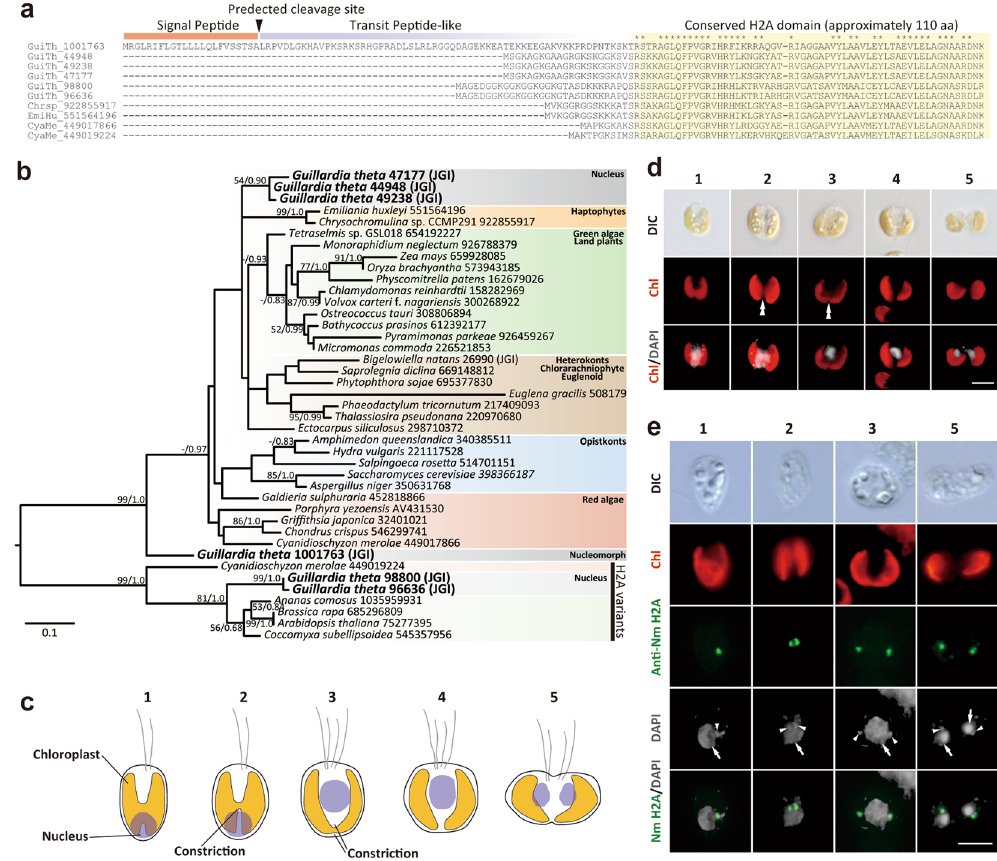
Figure 2. Identification of the nucleus-encoded nucleomorph-targeted histone H2A in G . theta . ( a ) Alignment of the N-terminal sequences of histone H2A proteins. The N-terminal of the G . theta histone H2A (GuiTh_1001763) is composed of a signal peptide and a transit peptide-like sequence. No signal peptide is predicted in other G . theta nucleus-encoded histone H2A (GuiTh_44948, GuiTh_49238 and GuiTh_47177) or histone H2A variants (GuiTh_98800 and GuiTh_96636). Histone H2A sequences of the haptophyte Chrysochromulina sp. CCMP2919 (GI#922855917), the haptophyte Emiliania huxleyi (GI#551564196), and the red alga Cyanidioschyzon merolae (GI#449017866 and GI#449019224) were also used for the alignment. The asterisk indicates an amino acid that is identical in all sequences and the conserved region is boxed in yellow. ( b ) Phylogenetic tree of histone H2A inferred from 105 amino acid sequences. The histone H2A sequences of G . theta are indicated in bold and boxed in gray. H2A variants were used as the outgroup. The bootstrap value and Bayesian posterior probability are shown at the node when the values exceed 50% (bootstrap) or 0.80 (posterior probability). The JGI accession number or GI number is shown on the right side of the species name. ( c ) Schematic drawing of the classification of the cell cycle stages based on the localization of the nucleus and the shape of the chloroplast. ( d ) DAPI-staining images showing the representative cells of the stages 1 to 5. DIC, images of differential interference contact; Chl, chloroplast autofluorescence; Chl/DAPI, merged images of Chl and DAPI. The double arrowhead indicates constriction of the chloroplast division site. Scale bar = 5 µ m. ( e ) Immunofluorescent micrographs showing the localization of the nucleus-encoded nucleomorph H2A. DIC, images of differential interference contact; Chl, chloroplast autofluorescence; Anti-Nm H2A, nucleomorph H2A detected with the antibody; DAPI, DNA stained with DAPI; H2A/DAPI, merged images of H2A and DAPI. The arrow and arrowhead indicate DAPI signal of nucleus and nucleomorph, respectively. Scale bar = 5 µ